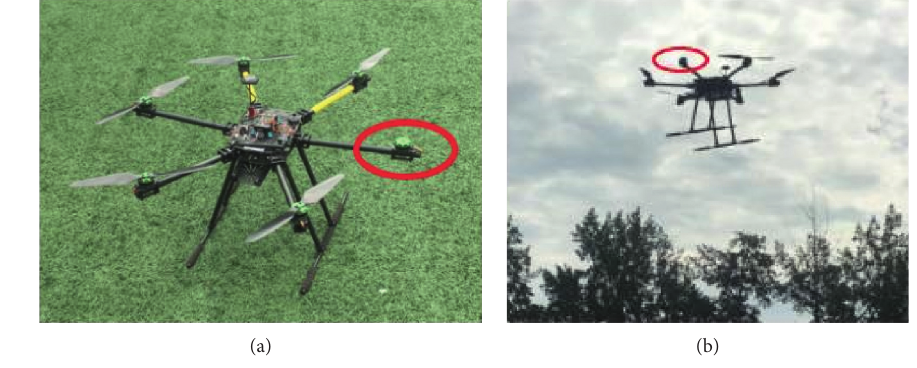
Figure 18: Actual flight